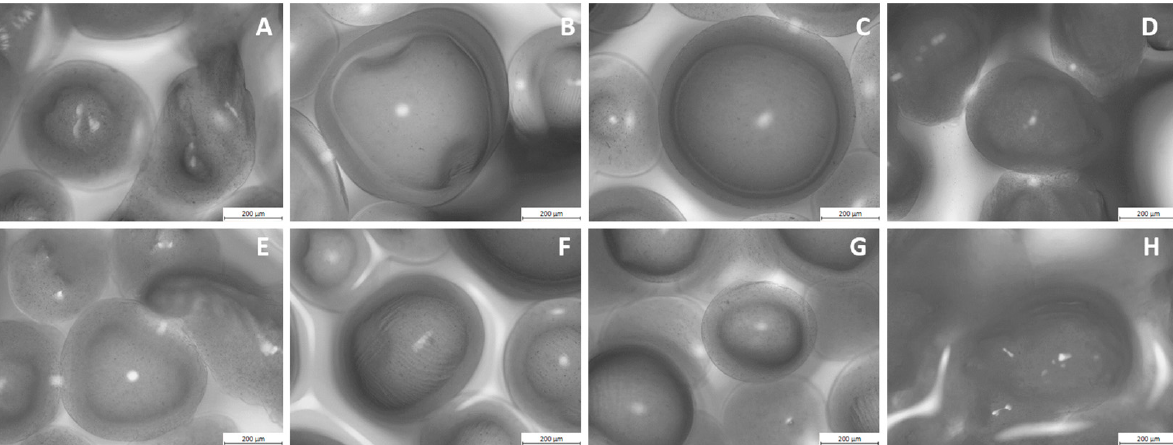
Figure 1. Microscopic images of microcapsules obtained from chokeberry juice and preparation with different coating materials: ( A ) chokeberry juice, coating: alginate; ( B ) chokeberry juice, coating: alginate + pectin; ( C ) chokeberry juice, coating: alginate + carrageenan; ( D ) chokeberry juice, coating: alginate + chitosan; ( E ) chokeberry preparation, coating: alginate; ( F ) chokeberry preparation, coating: alginate + pectin; ( G ) chokeberry preparation, coating: alginate + carrageenan; ( H ) chokeberry preparation, coating: alginate + chitosan.